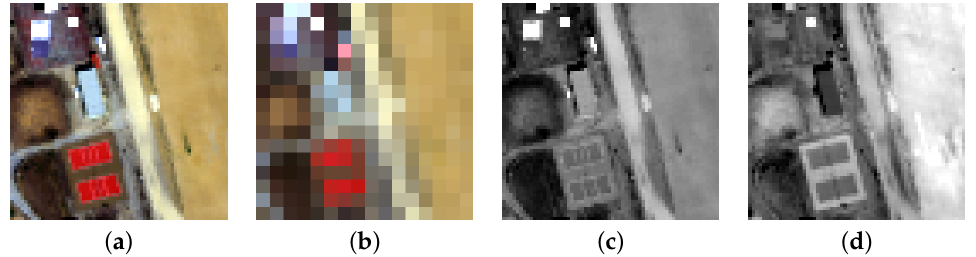
Figure 5. “Stadium” dataset (spatial resolutions in brackets; RGB representation for HS images).